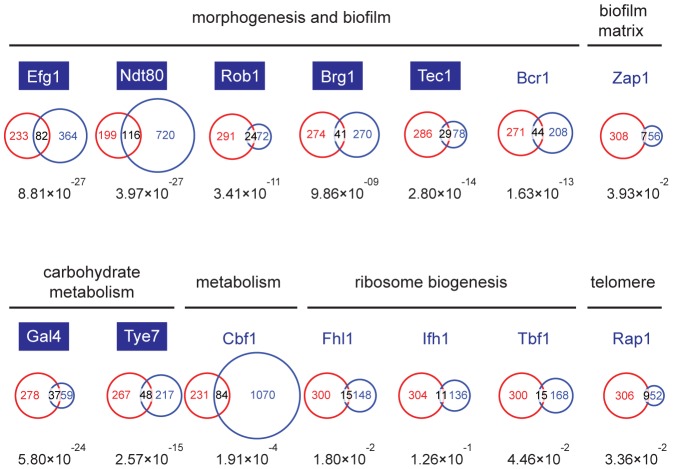
The Set3C is a co-factor of glycolysis and morphogenesis regulators.Statistical analysis of the overlaps of the target genes of selected transcription factors with the target gene set of Set3C in the individual phases. The TF target sets are shown in blue, the Set3C target sets in red, and the TFs are grouped according to the functions they are implicated in. The target sets of the TFs were imported from the following reports: Efg1, Ndt80, Rob1, Brg1, Tec1 and Bcr1 from [23], Zap1 from [24], Gal4 and Tye7 from [25], Cbf1, Fhl1, Ifh1, Tbf1 and Rap1 from [26]. The area of the circles and overlaps are proportional to the number of genes they consist of. For each overlap the P-value of hypergeometric testing is shown. Transcription factors that are themselves binding targets of Set3C in at least one morphological phase are placed in blue boxes.